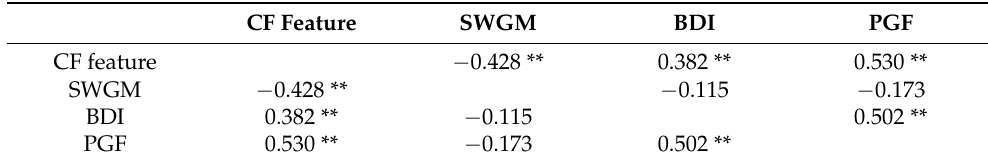
Table 3. Correlations between handwriting process measures, PGF ability, and BDI and CF feature: all samples.